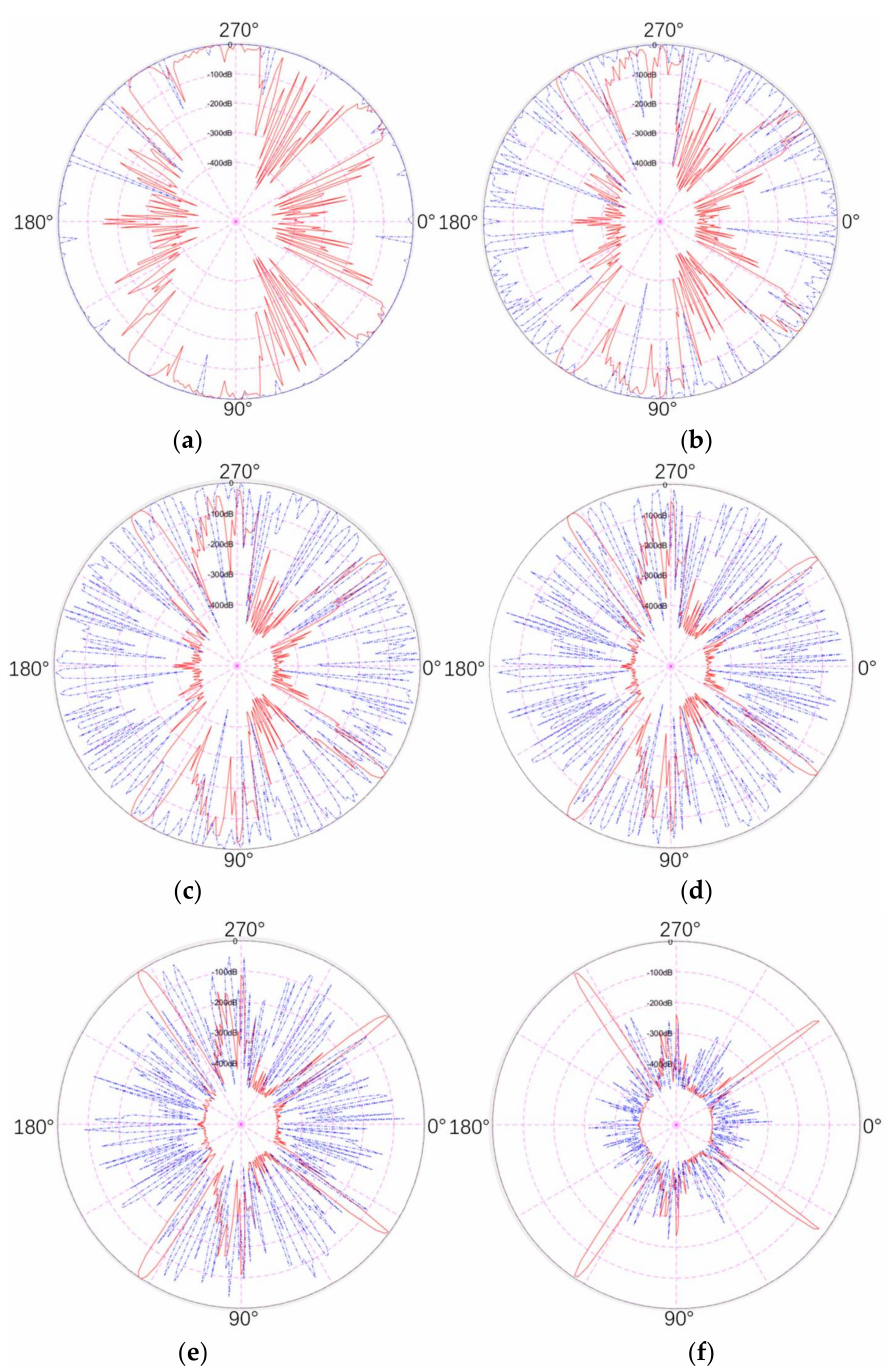
Figure 17. Comparison of detection probability between the quantum radar and the conventional radar at different distances (red line is P D , blue line is P DQ ). ( a ) 600 km, ( b ) 800 km, ( c ) 1000 km, ( d ) 1200 km, ( e ) 1400 km, ( f ) 1600